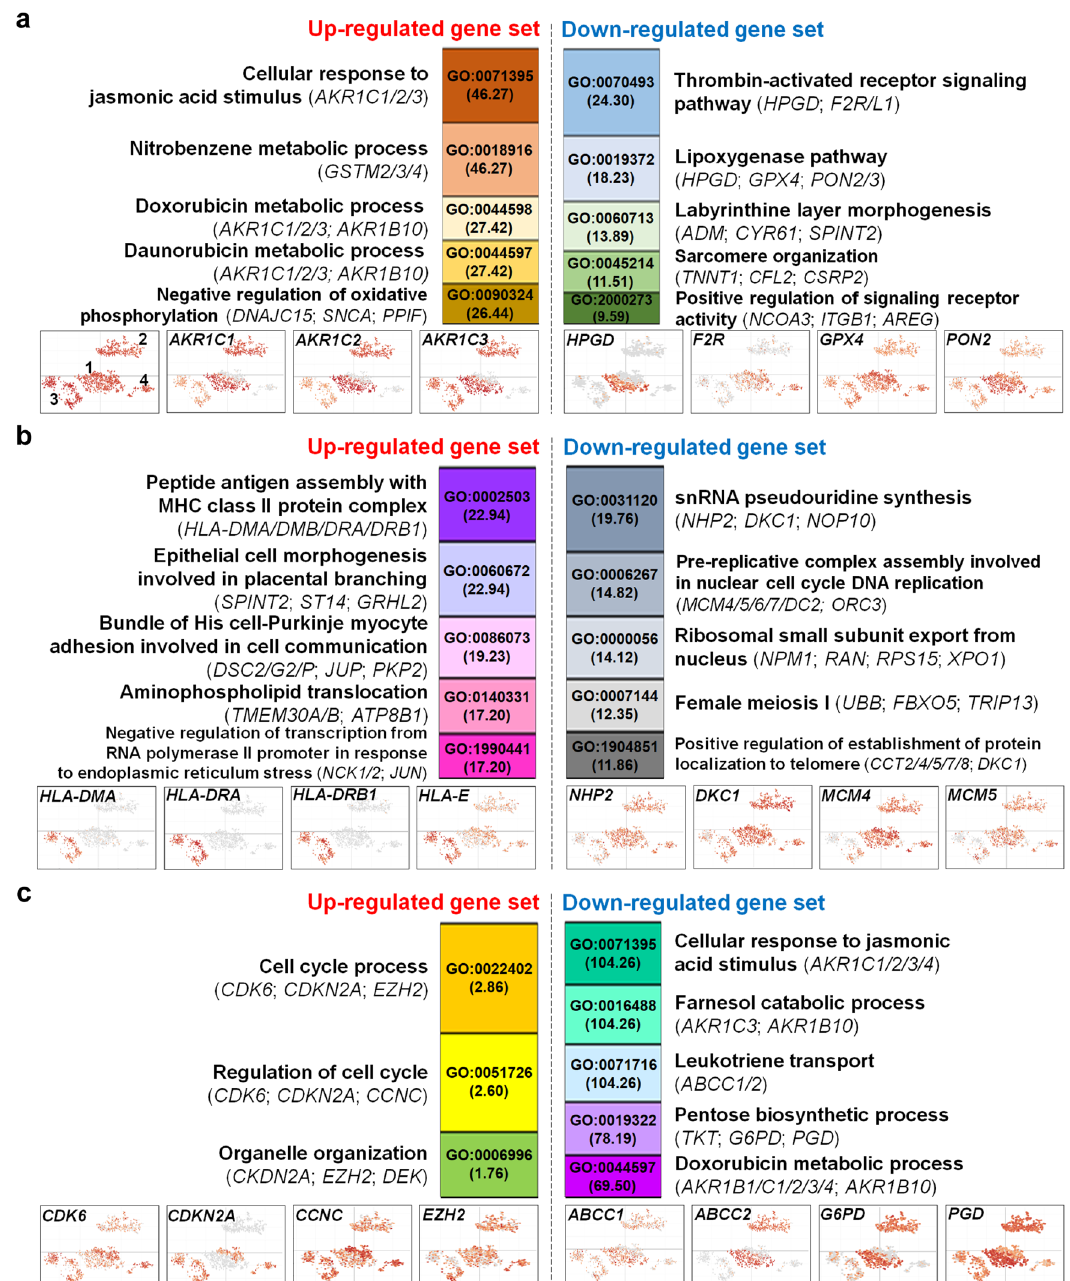
Fig. 3 GO of biological process overrepresented from GSEA. a – c Top 5 GO terms enriched with up ( n = 355)- and down ( n = 305)-regulated genes in Cluster 2 in ( a ), up ( n = 939)- and down ( n = 1,172)-regulated genes in Cluster 3 in ( b ) and up ( n = 199)- and down ( n = 226)-regulated genes in Cluster 4 in ( c ) when individually compared with Cluster 1 (Control cluster). The numbers in parentheses below GO IDs in individual bars and gene names in parentheses below GO descriptions indicate enrichment values at FDR-corrected P value < 0.05 and primary contributors to overrepresentation of the top 5 biological processes per gene set, respectively. Expression maps are presented below GO bars to visualize differential expression of selected DEGs. Reference expression map shown in lower panel ( a ) contains information on a position of clusters in two dimensions. See Supplementary Data 1 for full gene